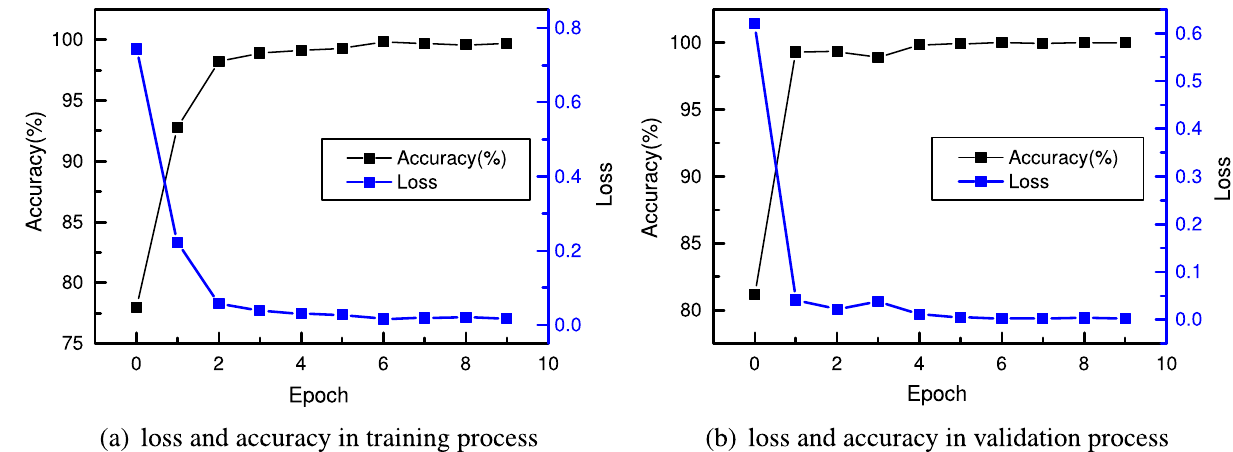
Figure 13. Loss and accuracy of CNN with two cells in the training process ( a ) and validation process ( b ).